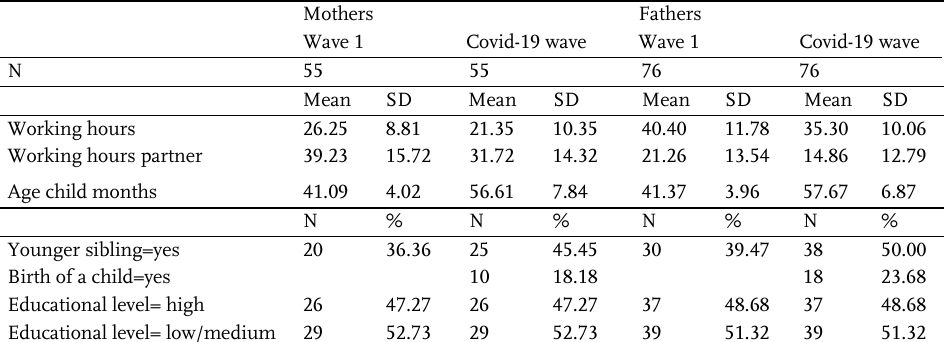
Table 1 : Sample descriptives of the working fathers and mothers selected in our sample Mothers Fathers Wave 1 Wave